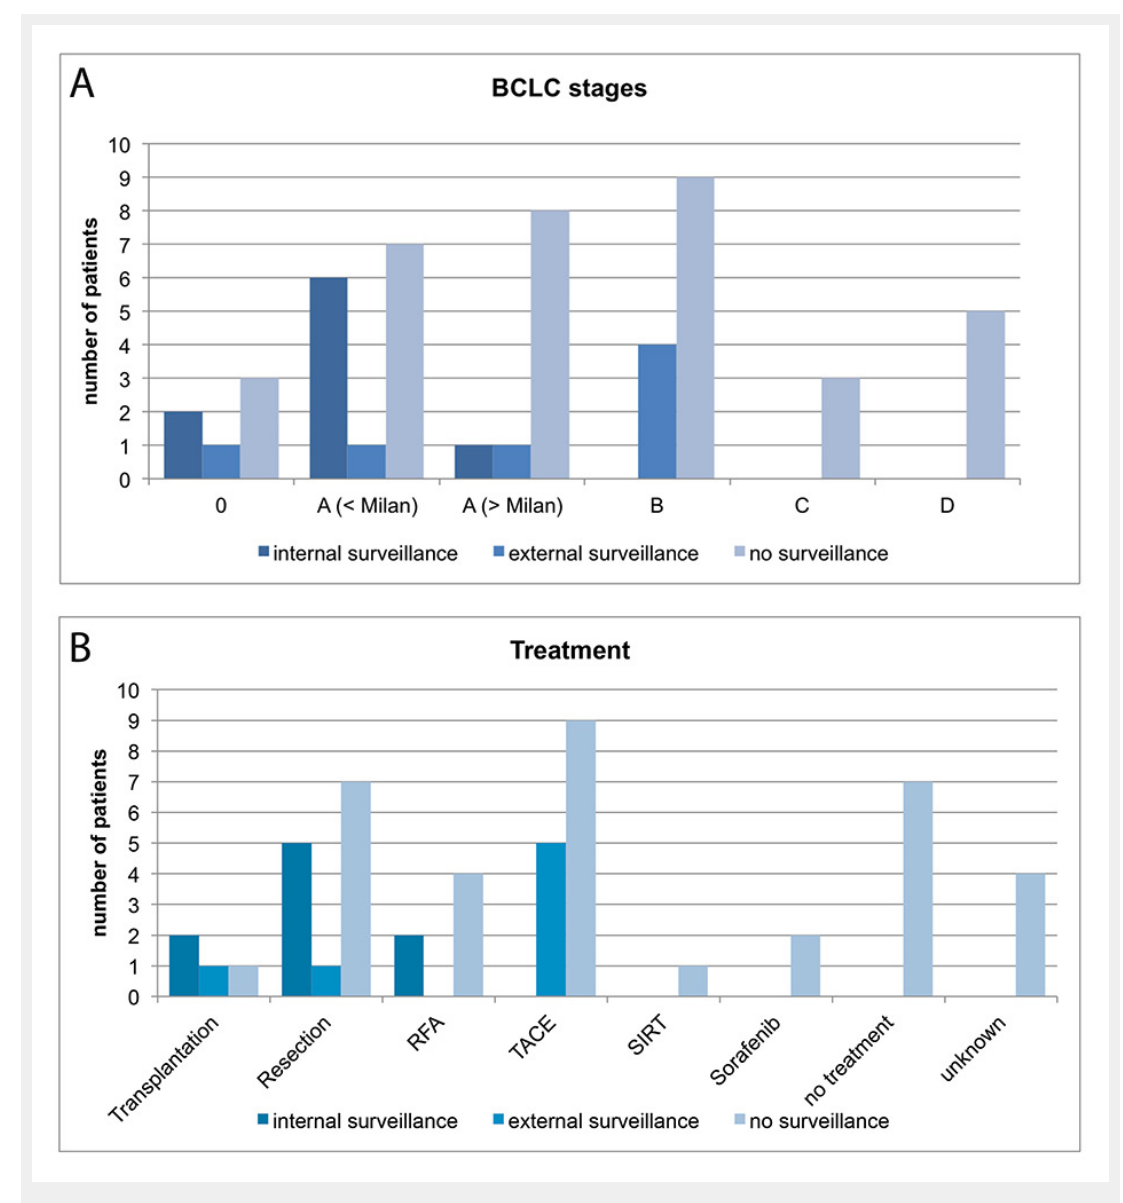
Figure 4 (A) Barcelona Clinic Liver Cancer (BCLC) staging of internal surveillance (dark blue), external surveillance (blue), no surveillance (light blue). Stages 0 and A are considered as very early and early stages. BCLC stage A patients were subdivided in those within the Milan criteria, and those with tumours outside the Milan criteria. (B) Applied treatments for HCCs detected in internal surveillance (dark blue), external surveillance (blue), or in patients without surveillance (light blue). HCC = hepatocellular cancer; RFA = radiofrequency ablation; SIRT = selective internal radiotherapy; TACE = transarterial